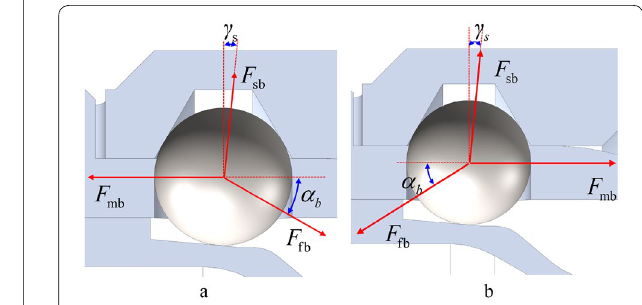
Figure 8 Analysis of the force on the ball: a) RCM is under the pulling force, b) RCM is under